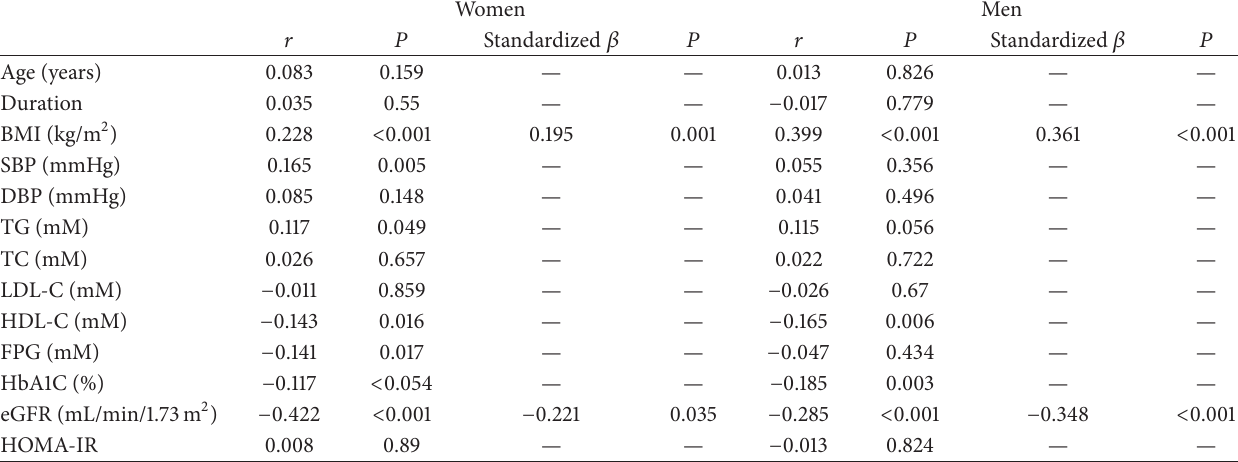
Table 2: Pearson’s correlation and stepwise regression analysis of determinants of